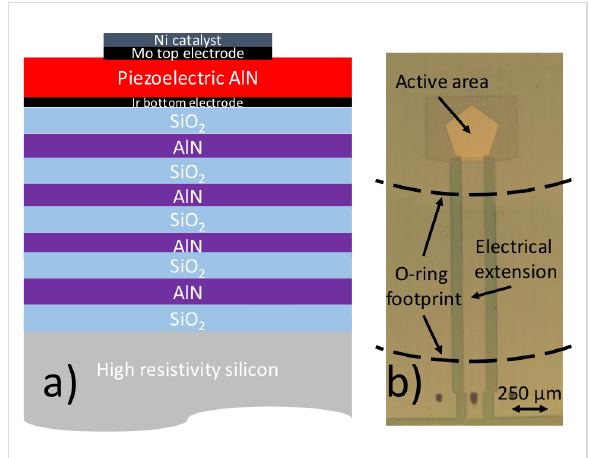
Figure 8: a) Schematic cross section of a typical AlN-based SMR showing the Ir/AlN/Mo/Ni piezoelectric stack and the acoustic reflector and b) optical picture of a device showing the electrical extensions and the footprint of the fluidic O-ring on the device.